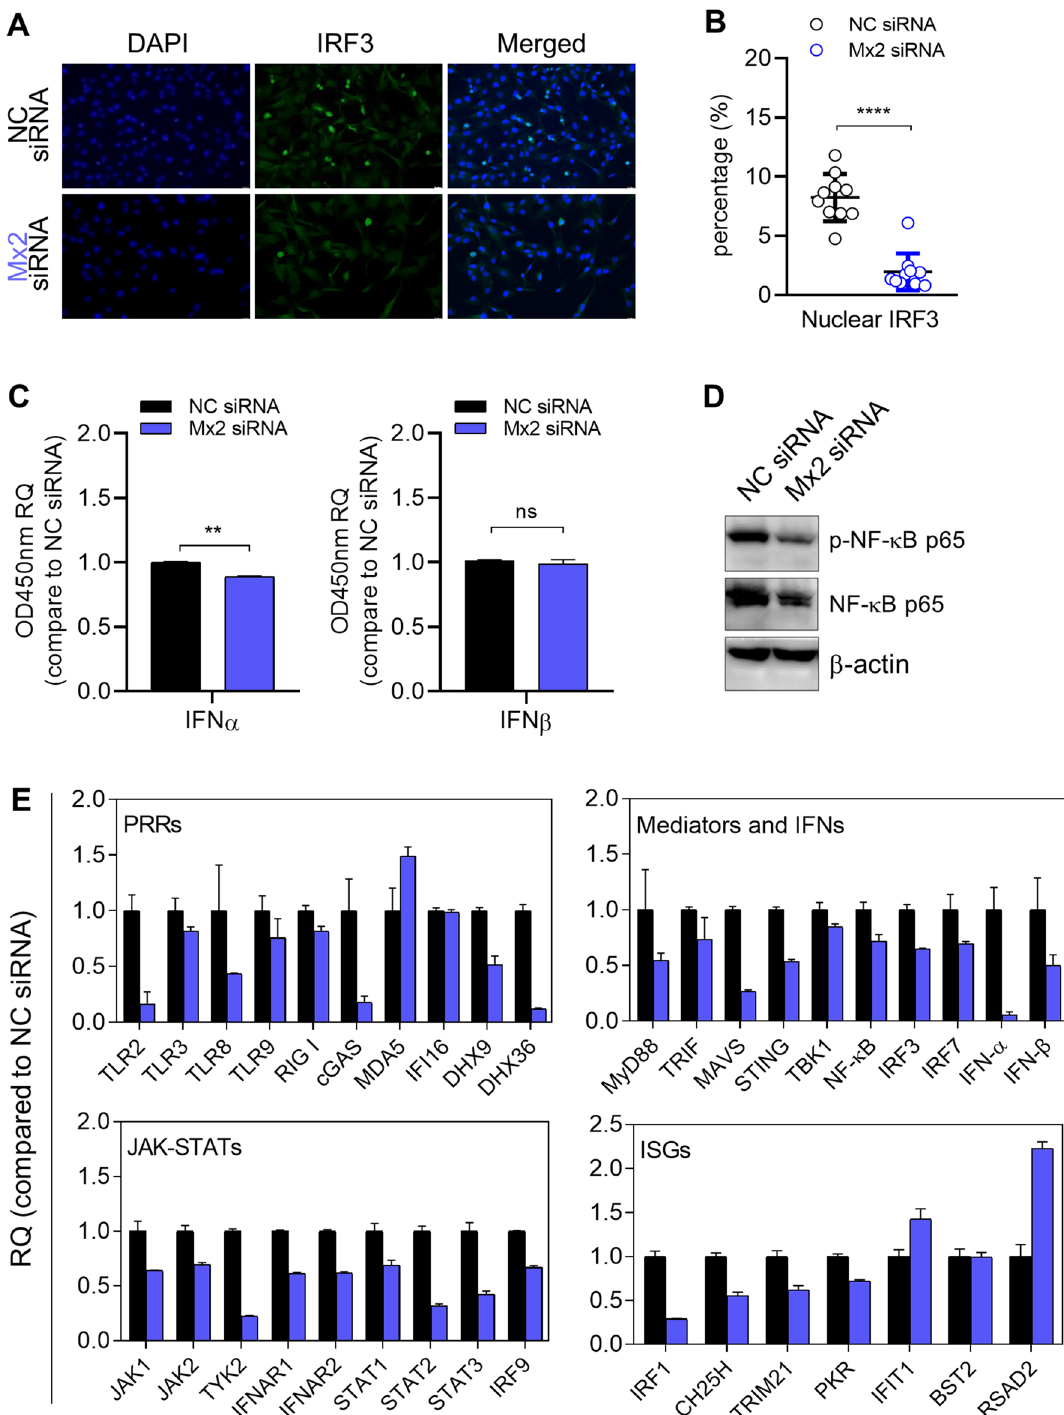
Figure 4. The effects of Mx2 depletion on antiviral innate response and intrinsic mRNA accumulation of innate immune genes in resistant A172 cells. ( A ) Investigation of nuclear IRF3 in A172 cells via immunofluorescence staining. ( B ) Quantification of IRF3 localized in the A172 nucleus by automatic counting using Image J software. 10–15 fields of each slide were randomly chosen for counting the numbers of IRF3-DAPI coincident dots. ( C ) ELISA quantification of secreted IFNα and IFNβ in cell supernatant. RQ: relative quantity, values that correspond to optical densities at OD 450 nm compared to values in NC siRNA-transfected A172 cells. (* p < 0.05; ** p < 0.01; compared with NC siRNA- treated A172 cells. Error bars represent SD.) ( D ) Expression of effector proteins associated with the NF-κB signaling pathway. Blots were cut and probed with indicated antibodies, respectively. β-actin serves as a loading control. ( E ) mRNA accumulation of indicated immune genes in Mx2-depleted A172 cells. Mx2-depleted or mock-depleted A172 cells were harvested at 24 h post-transfection. Total RNA was isolated and analyzed by qPCR assay for mRNA levels of indicated immune genes. Used primers are shown in Table 3. RQ: relative quantity, compared to transcript levels in mock-depleted A172 cells. Bar, mean ± SD. GAPDH serves as a normalization